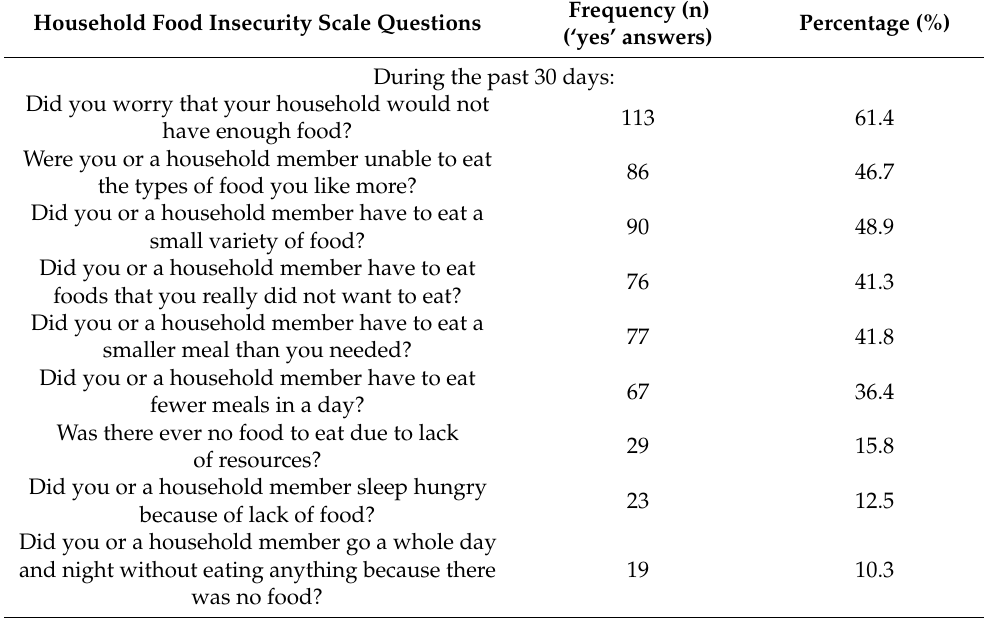
Table 4. Household food insecurity scale results breakdown per question ( n = 184).